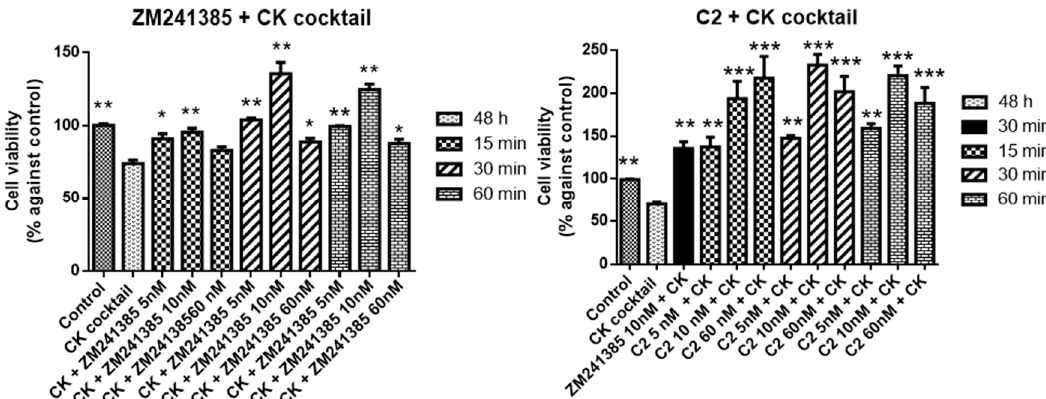
Figure 6. Restoring effects of ZM241385 and C 2 against CK aggression on mixed glial cell culture. Results represent the average of 3–5 independent experiments. * p < 0.05, ** p < 0.01, *** p < 0.001 of treated cells against CK.